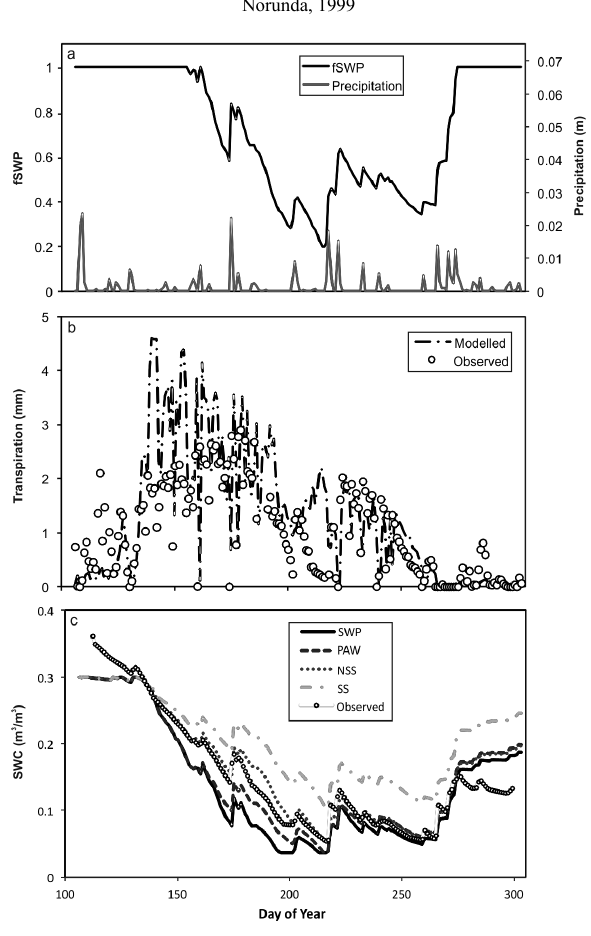
f03 Fig. 3. (a) Modelled f SWP and measured precipitation for a mixed Norway spruce and Scots pine stand at Norunda in 1999 using the PAW method; (b) Observed and modelled transpiration for the same year, stand and soil water calculation method; (c) Observed and modelled soil water content (SWC) using all four methods that re- late soil water to g sto (see methods section for details).